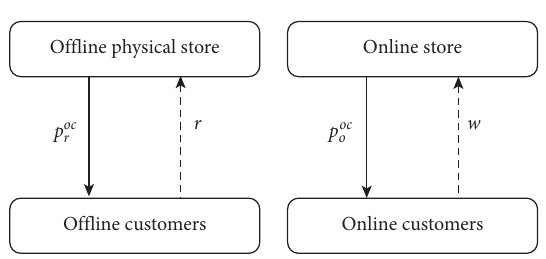
Figure 1: Original channel return